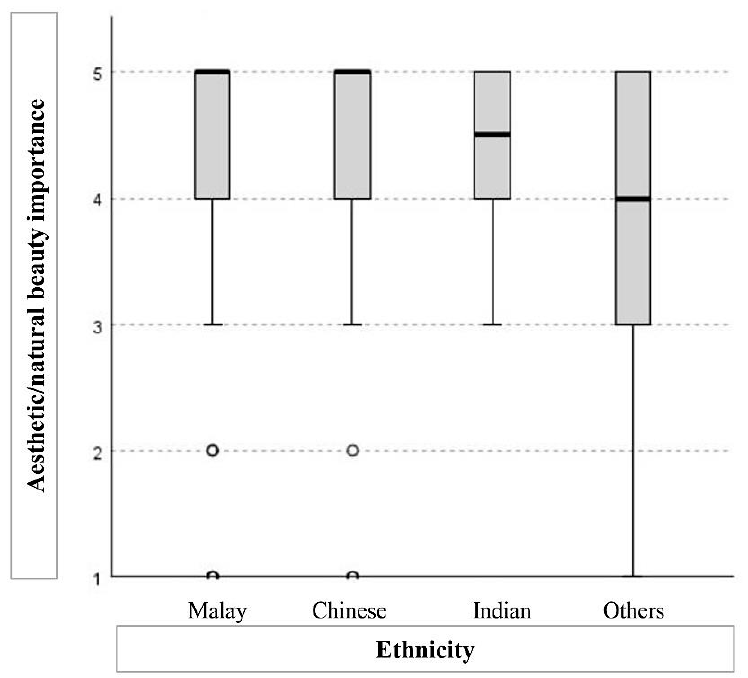
Figure 5. Independent samples Kruskal–Wallis test between aesthetic/natural beauty importance and ethnic